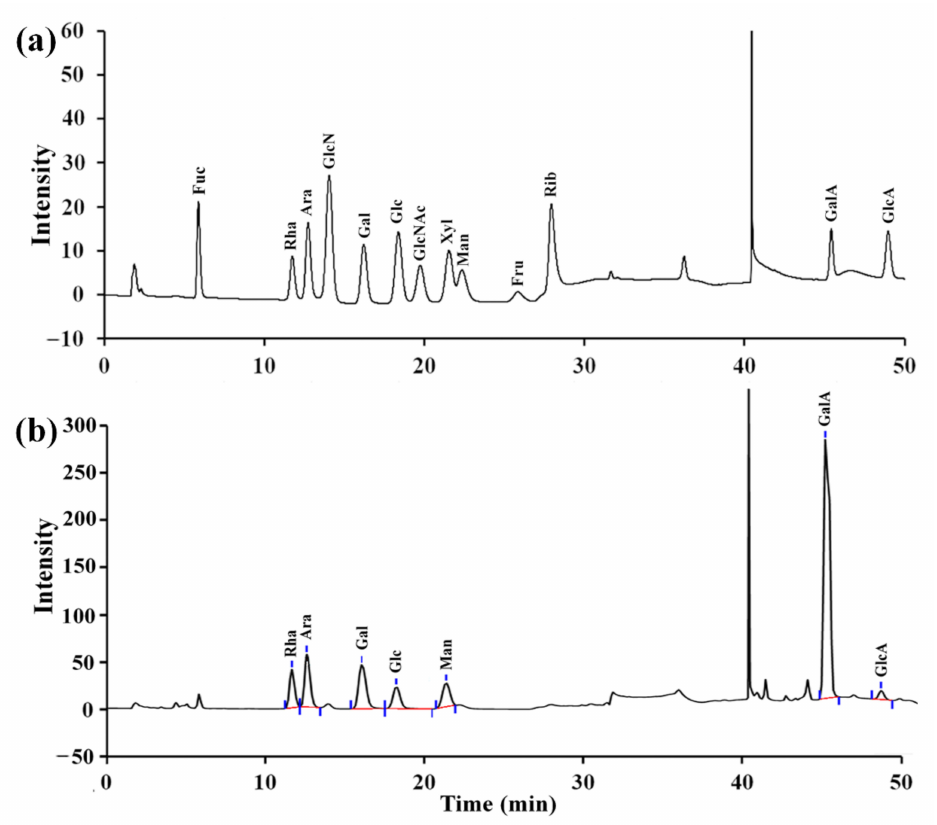
Figure 2. Monosaccharide composition of RPP-2a. ( a ) The profile of mixed monosaccharides stan- dards and ( b ) monosaccharides in